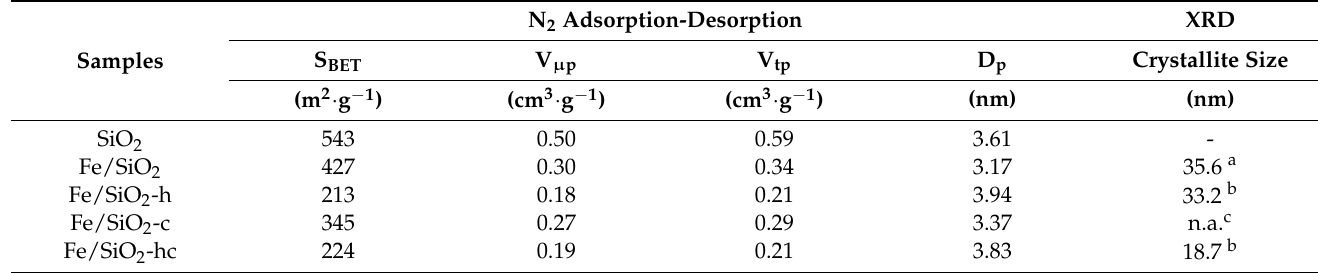
Table 1. Textural and structural characteristics of